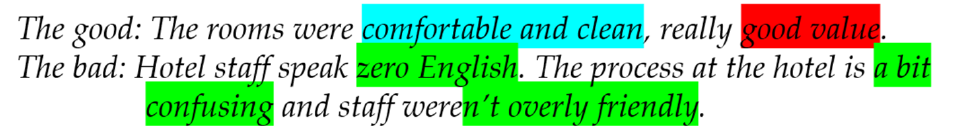
Figure 3. An example for document-level ABSA containing aspects: SERVICE (colored in green), CLEANESS (colored in blue), and PRICE (colored in red).